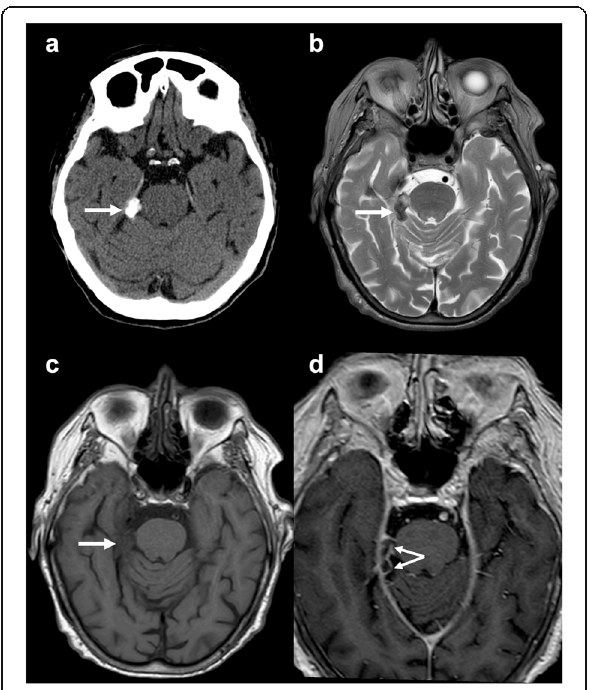
Fig. 6 Teflon-induced calcified granuloma. Axial unenhanced CT ( a ), T2-weighted ( b ), unenhanced ( c ) and post-contrast ( d ) T1-weighted images depicting a calcified mass (arrow), with heterogeneous signal and rim enhancement